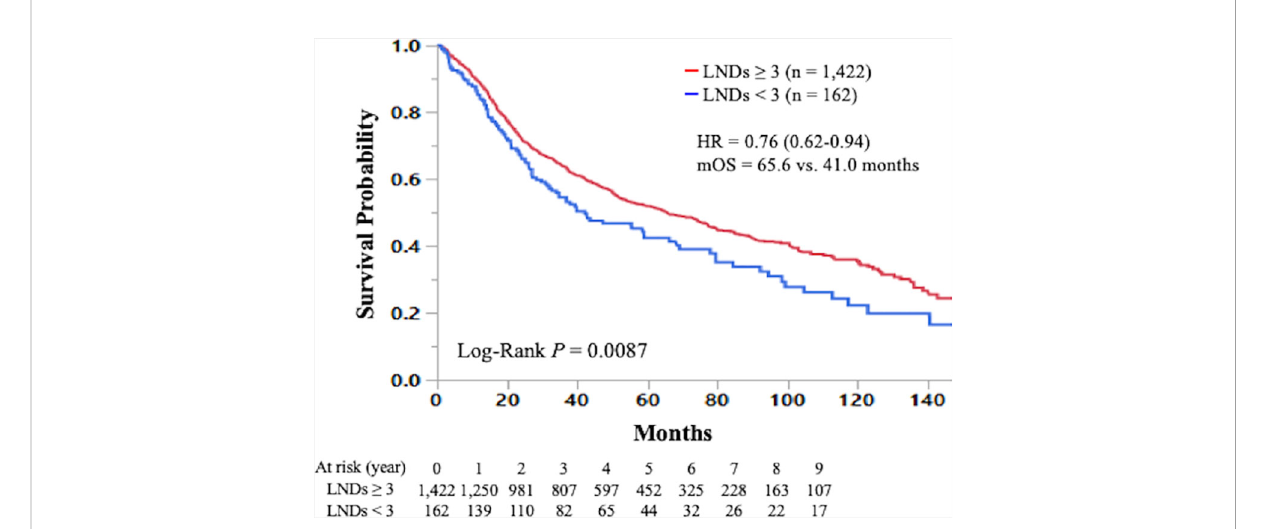
FIGURE 4 Kaplan-Meier curve of overall survival in early-stage small cell lung cancer patients who underwent curative lobectomy according to the number of lymph nodes dissected ( ≥ 3 vs. <3) is shown. LND; lymph node dissected; HR, hazard ratio; mOS, median overall